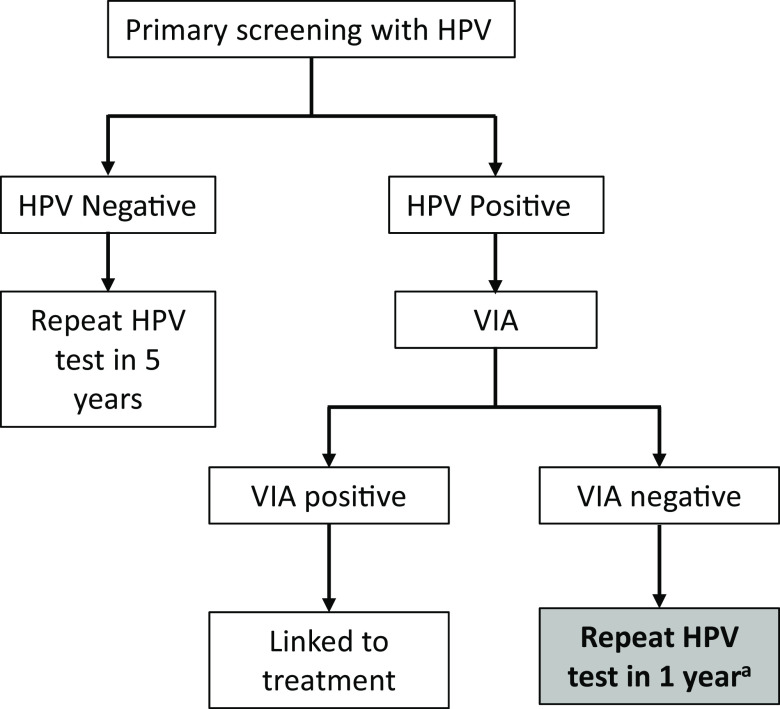
Cervical Cancer Screening Algorithm Followed in the Scale-Up Project, HondurasAbbreviations: HPV, human papillomavirus; VIA, visual inspection with acetic acid.a The current evaluation focuses on HPV-positive, VIA-negative women due for repeat HPV testing at 1 year.